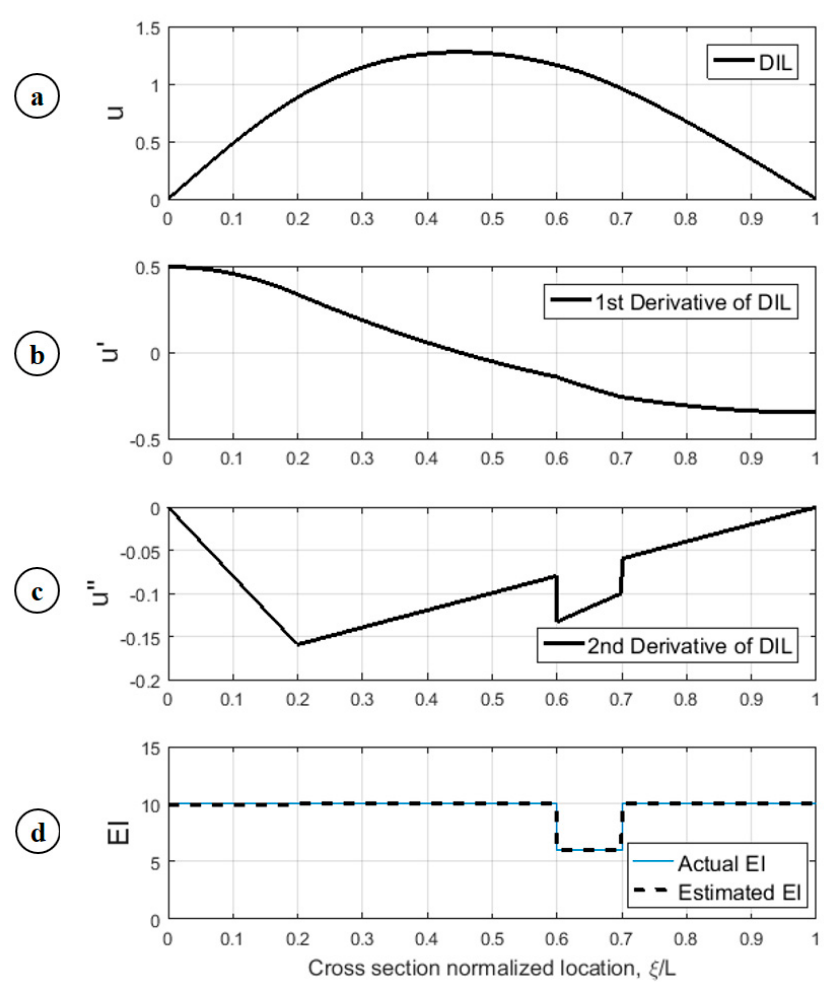
Figure 4. Example-I analysis results ( a ) recorded Deflection Influence Line (DIL) ( b ) first derivative of DIL ( c ) second derivative of DIL ( d ) beam flexural rigidity estimation (FRE). DIL ( c ) second derivative of DIL ( d ) beam flexural rigidity estimation